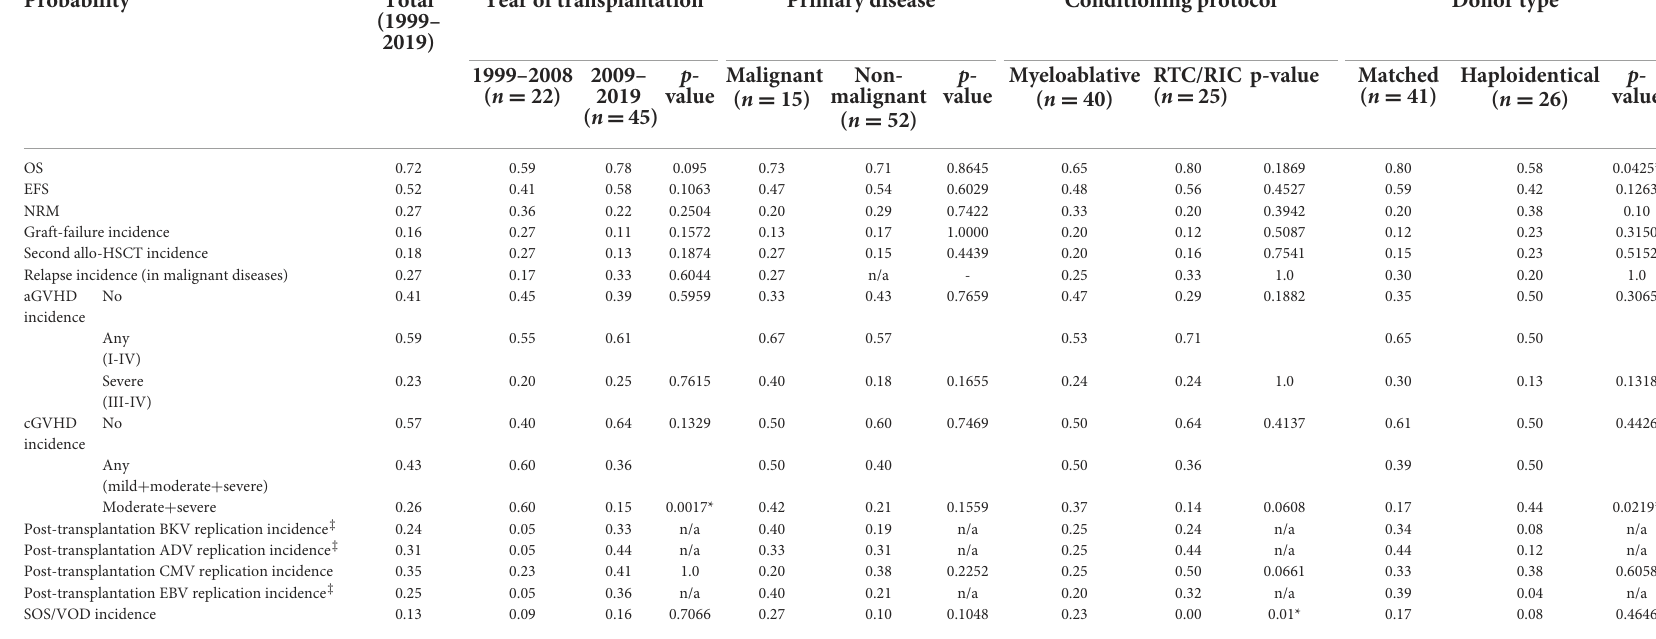
TABLE 2 Impact of risk factors on the outcome and incidence of posttransplant complications. Probability